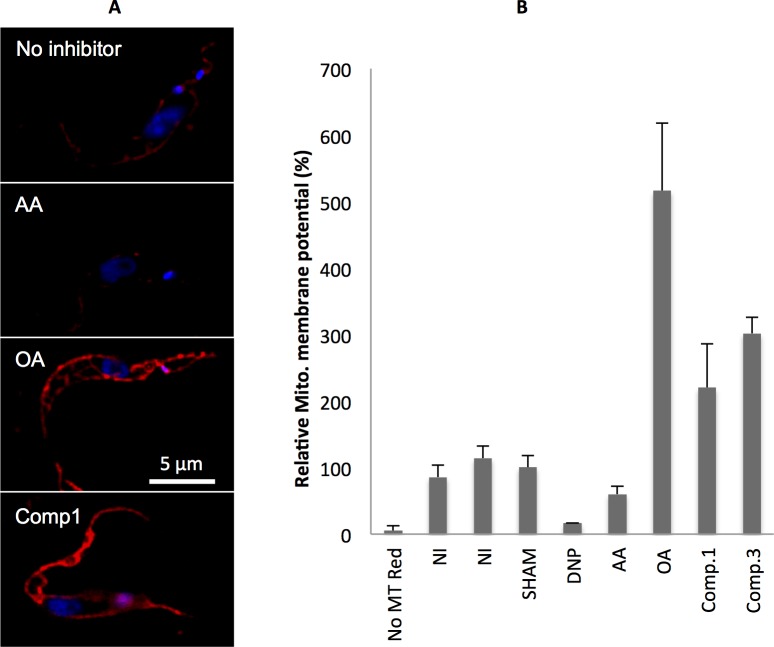
Effects of compounds on mitochondrial membrane potential.PF T. brucei were incubated with inhibitors and MitoTracker Red CMXRos, which is an indicator of the mitochondrial membrane potential (Δψm). (A) MitoTracker-loaded cells were imaged to qualitatively detect differences in the Δψm. Complex III inhibitor, antimycin A (AA at 2 μM) noticeably reduced MitoTracker Red CMXRos uptake, while the FoF1-ATP synthase (complex V) inhibitor oligomycin A (OA at 2 μM) and compound 1 at 40 μM clearly enhanced MitoTracker Red CMXRos uptake as compared with the uninhibited control. (B) Fluorescence of MitoTracker-loaded cells were quantified using a microplate reader and normalised to MitoTracker green fluorescence. Data were consistent with microscope observations in which inhibitors of the electron transport chain such as Antimycin A (AA at 2 μM), or protonophores such as 2,4-dinitrophenol (DNP at 1 mM) decrease the mitochondrial membrane potential (Δψm), while inhibitors of the FoF1-ATP synthase such as Oligomycin A (OA at 2 μM) elevate the Δψm. Compounds 1 and 3 at 40 μM elevated the Δψm indicating that they, like OA, target the FoF1-ATP synthase.